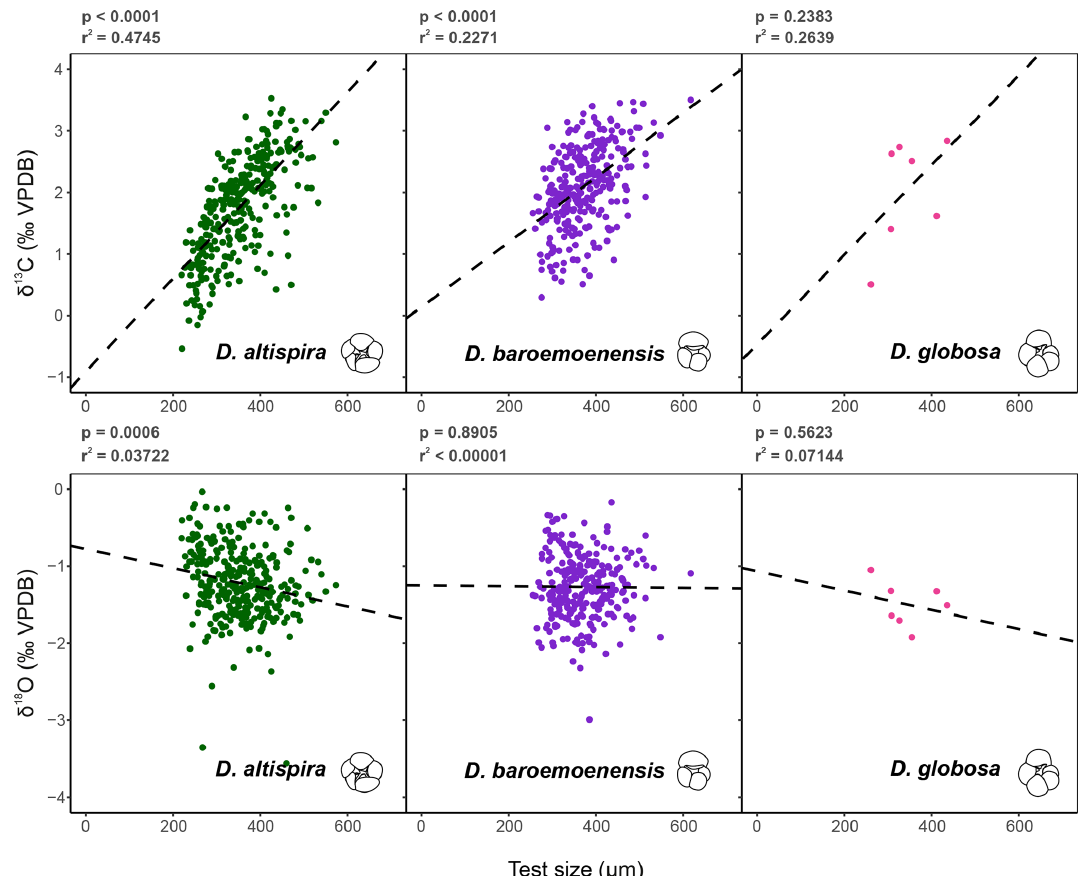
Figure 3. Test size – δ 13 C and δ 18 O relationships for the three species of Dentoglobigerina that underwent extinction through the study section. Trend lines for each species represent linear regressions based on the entire per species dataset (dashed line). Significance ( p ) and measure of fit ( r 2 ) were calculated for each linear